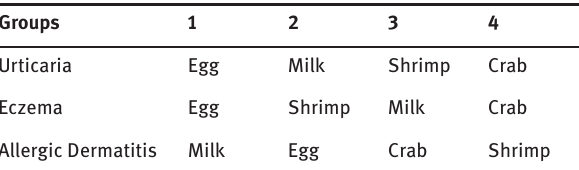
Table 4: Sequence of positive rates of IgG antibody of 4 kinds of foods in the 3 groups of allergy dermatosis.